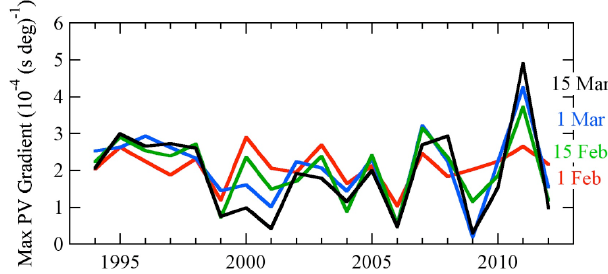
Figure 12. Relationship between SAOZ total column ozone loss and V calculated from ERA-Interim temperatures. Left: V indicative of potential chorine activation. The selection of sunlit V increases the correlation from 0.88 to 0.95. Although V